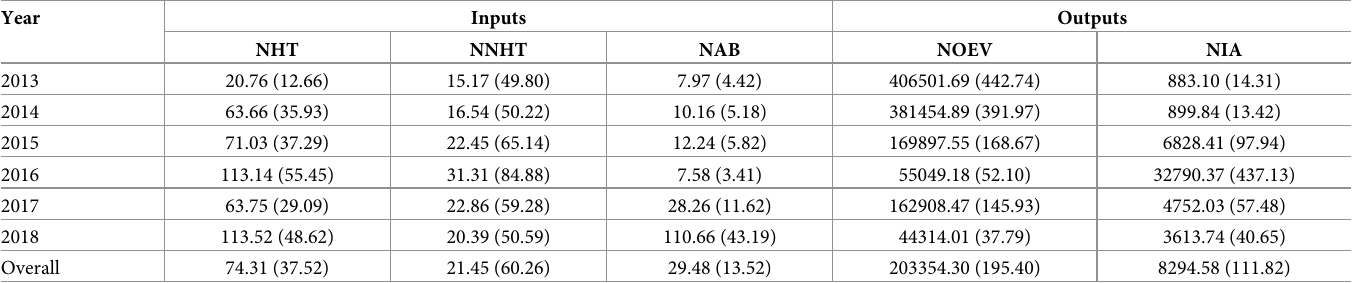
Table 4. Achievable reductions for inputs and improvement for outputs from 2013 to